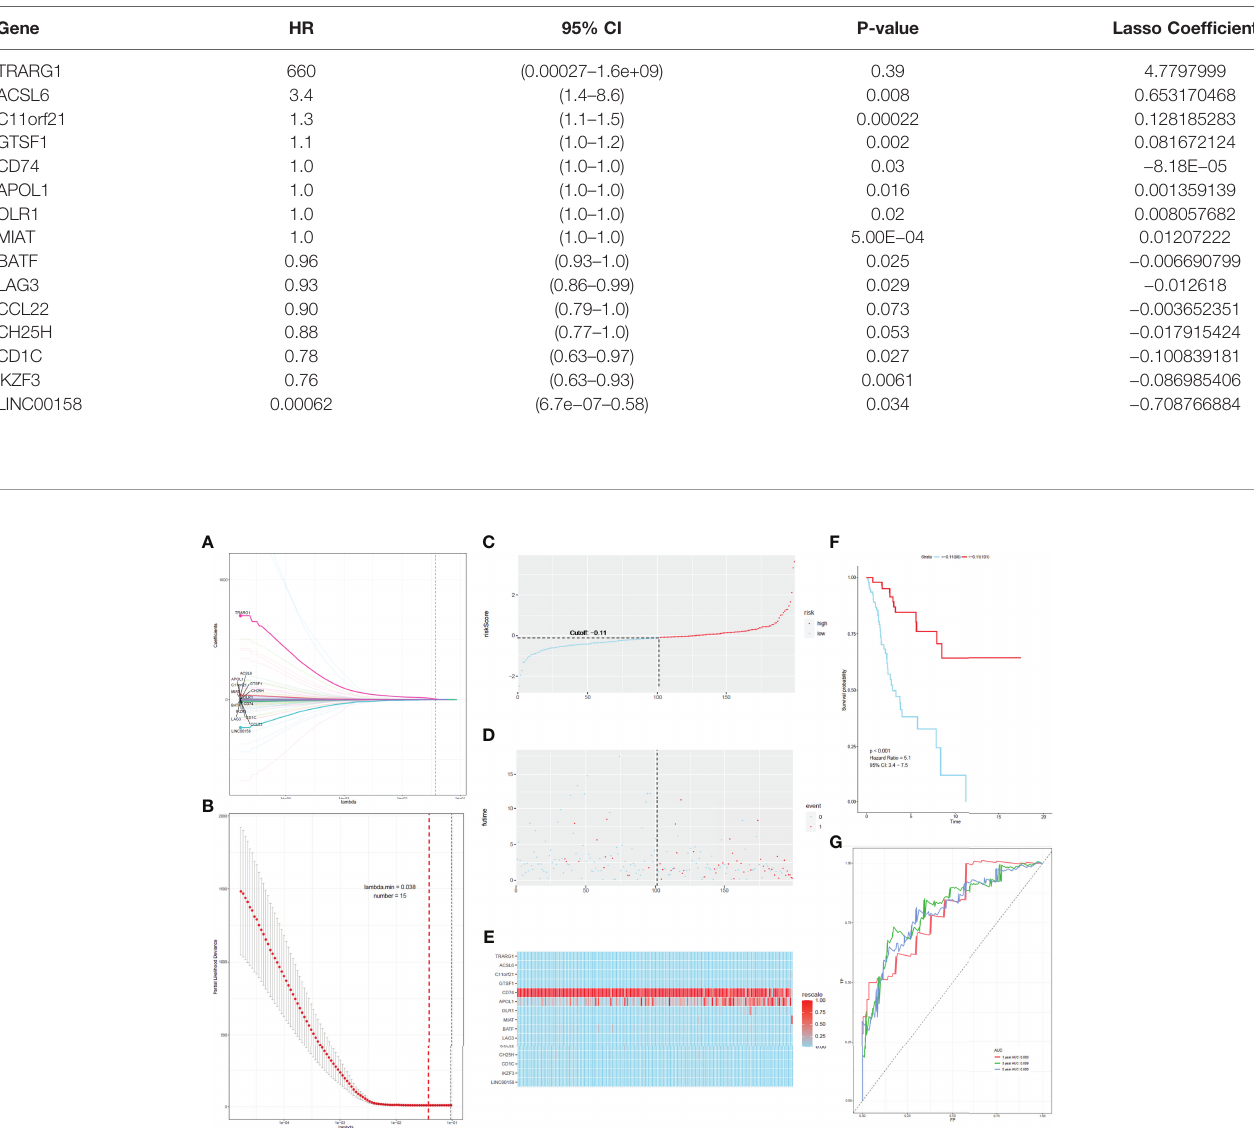
TABLE 2 | Fifteen genes from LASSO analysis.